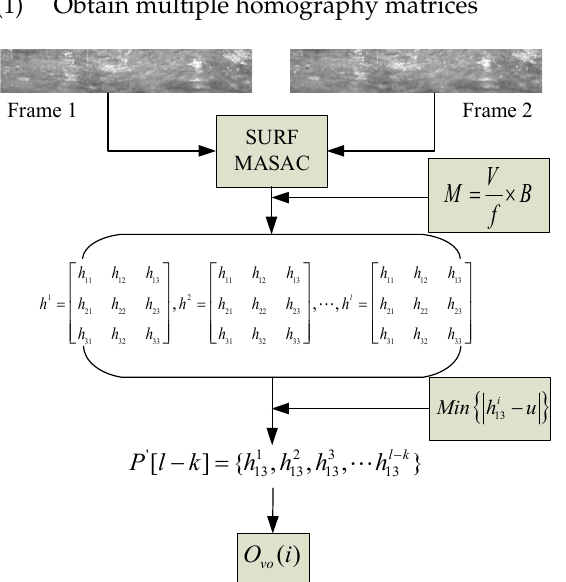
Figure 2. LHOO algorithm flowchart. The current image group is iterated repeatedly based on the SURF and MSAC algo- rithms to obtain l homography Algorithm 1. Pseudo-code: LHOO algorithm